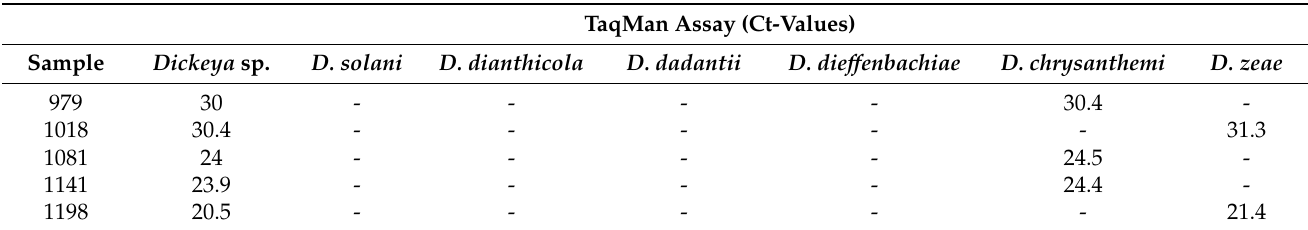
Table 4. Results of leaf samples collected at grower D in 2019 were positive with a